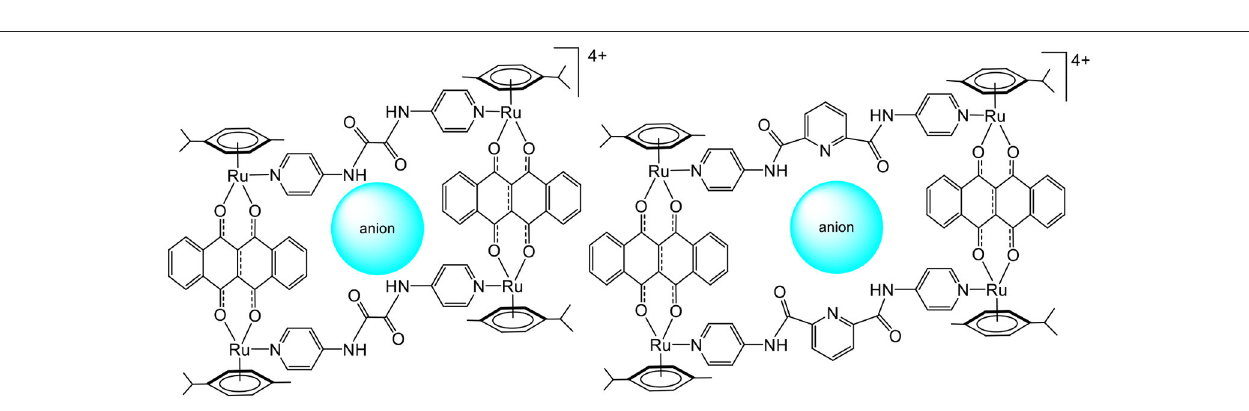
FIGURE 2 | Sensing of polyanionic species in tetranuclear arene ruthenium metalla-assemblies (Vajpayee et al., 2011; Mishra et al., 2012).